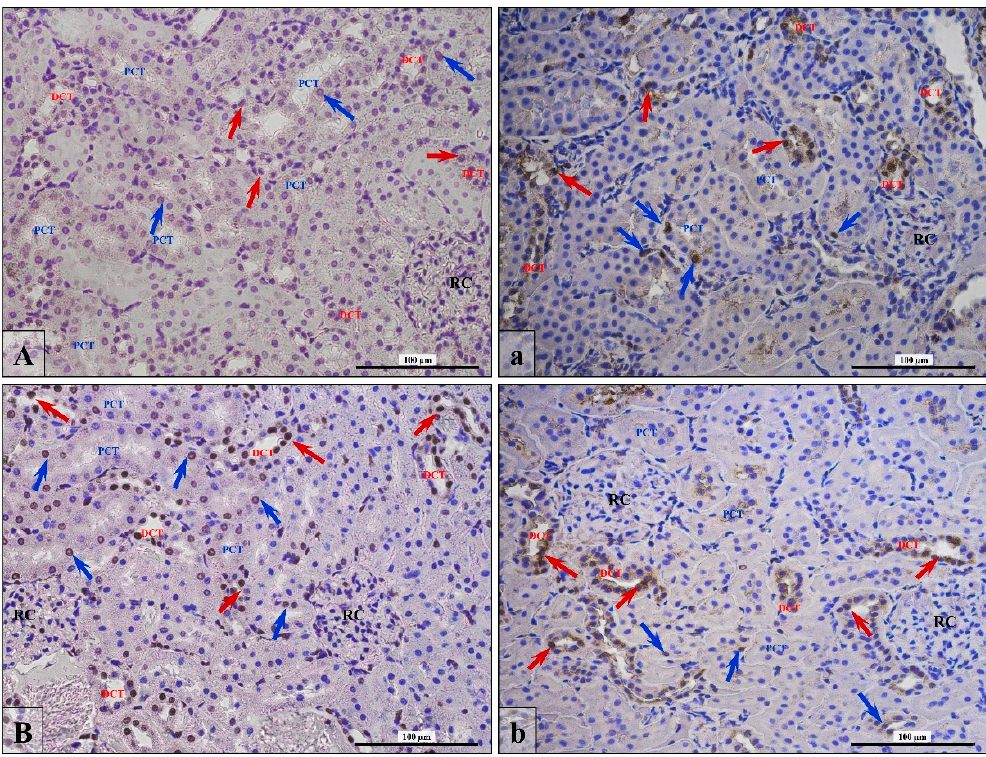
Figure 3. Representative microphotography showing TUNEL reaction ( A , B ) and PCNA-positive cells ( a , b ) in control ( A , a ) and finasteride-treated ( B , b ) rats. Red arrows indicate positive signaling in nuclei of PCT; blue arrows indicate positive signaling in nuclei of the DCT. Scale bar from objective magnification × 40 ( A , a ; B , b ) is 100 µ m.